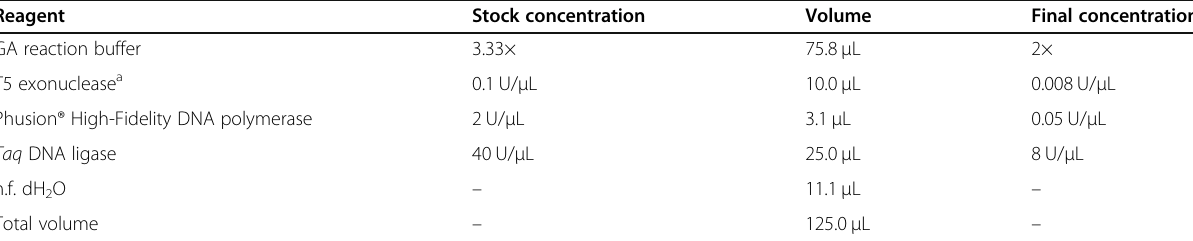
Table 3 GA enzymatic premix (2×, 125 μ L) Reagent